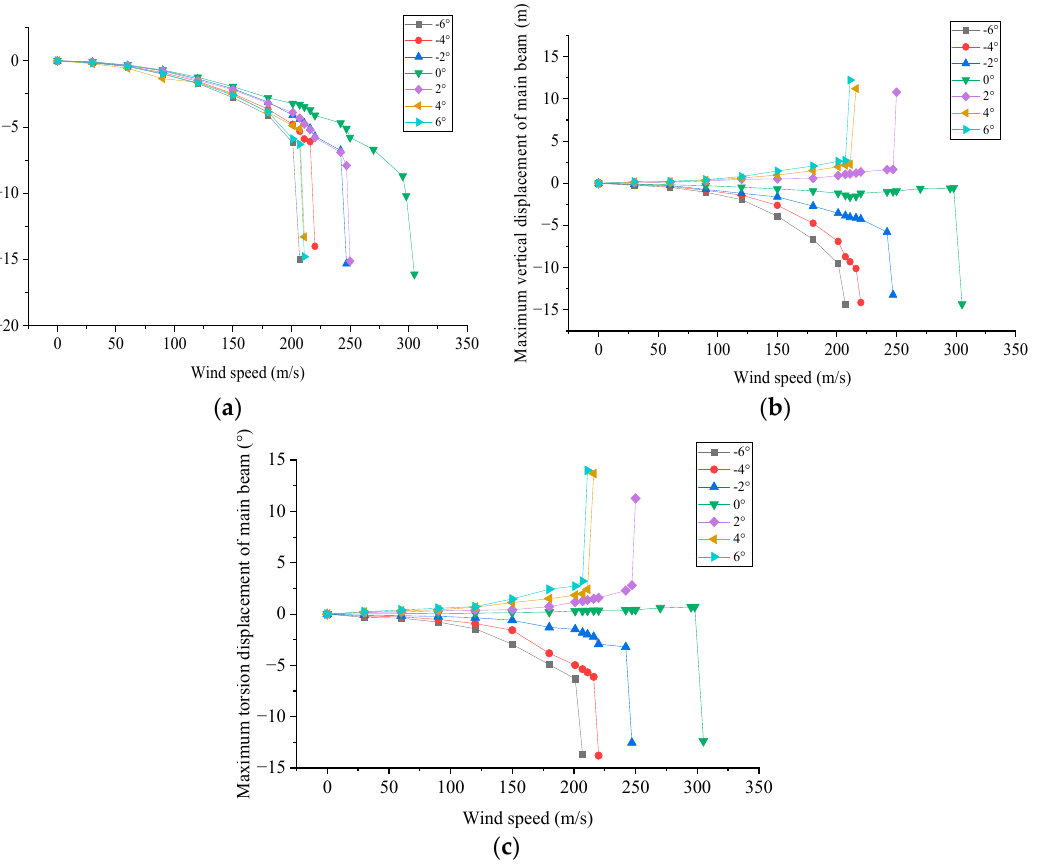
Figure 10. Maximum displacement curve of the main beam with wind speed under different initial wind attack angles; ( a ) Lateral displacement ( b ) Vertical displacement; ( c ) Torsion angle.